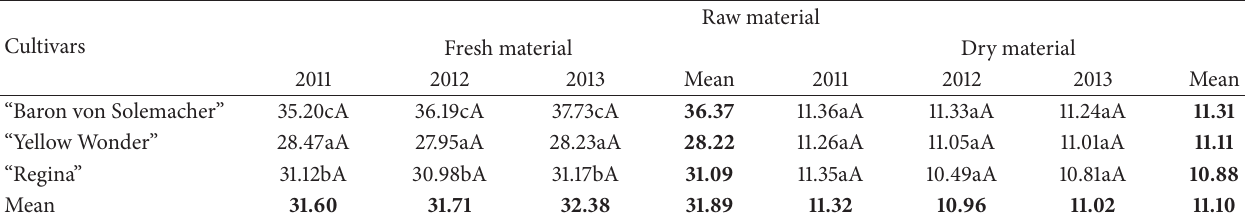
Table 2: Dry matter (%) content in raw and dried fruits as well as moisture content in dried fruits in successive years of the study. Cultivars